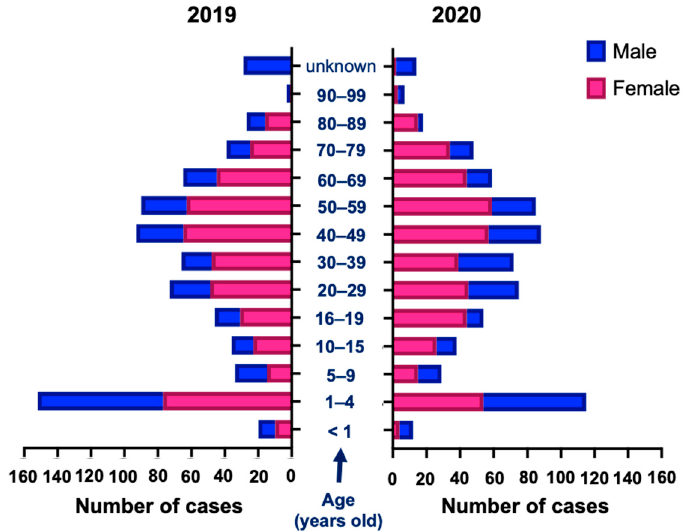
Figure 3. Distribution of cases by age group and sex during 2019 and 2020. Comparing 2019 and 2020, the distributions were as follows by age group and sex: <1 years old (2.14% F; 3.28% M vs. 0.91% F; 2.93% M), 1–4 (16.45% F; 24.59% M vs. 12.24% F; 22.34% M), 5–9 (3.21%; 6.23% M vs. 3.40% F; 5.13% M), 10–15 (4.91%; 4.26% M vs. 5.90% F; 4.40% M), 16–19 (6.62%; 4.92% M vs. 9.98% F; 3.66% M), 20–29 (10.47%; 7.87% M vs. 10.20% F; 10.99% M), 30–39 (10.26%; 5.90% M vs. 8.84% F; 12.09%